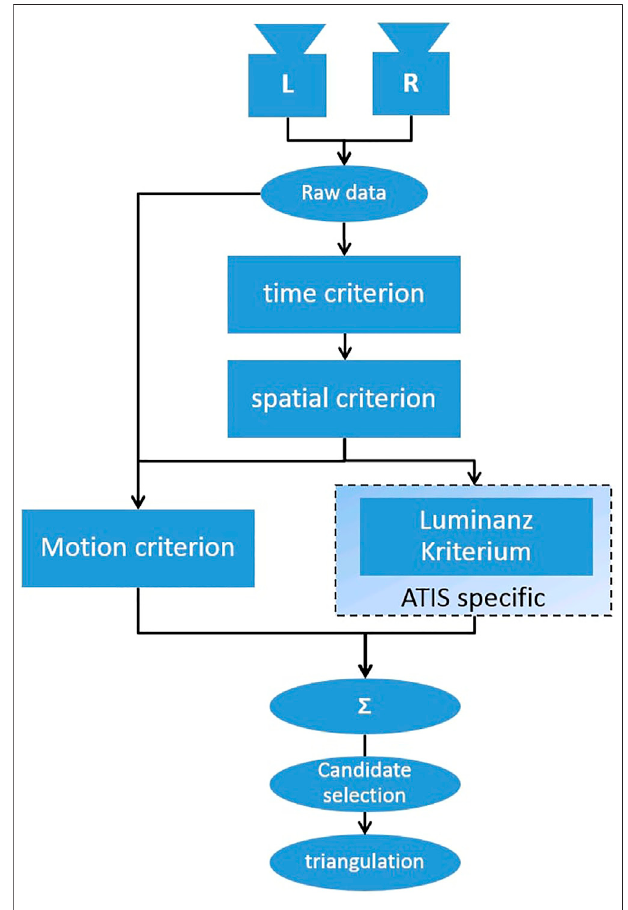
FIGURE 3 | High-level fl ow chart of the evaluated algorithm. Correspondences are determined by four criterions; the time criterion comparing event ’ s time stamps, the spatial criterion exploiting epipolar geometry, luminance criterion comparing luminance values and the motion criterion calculating motion fi